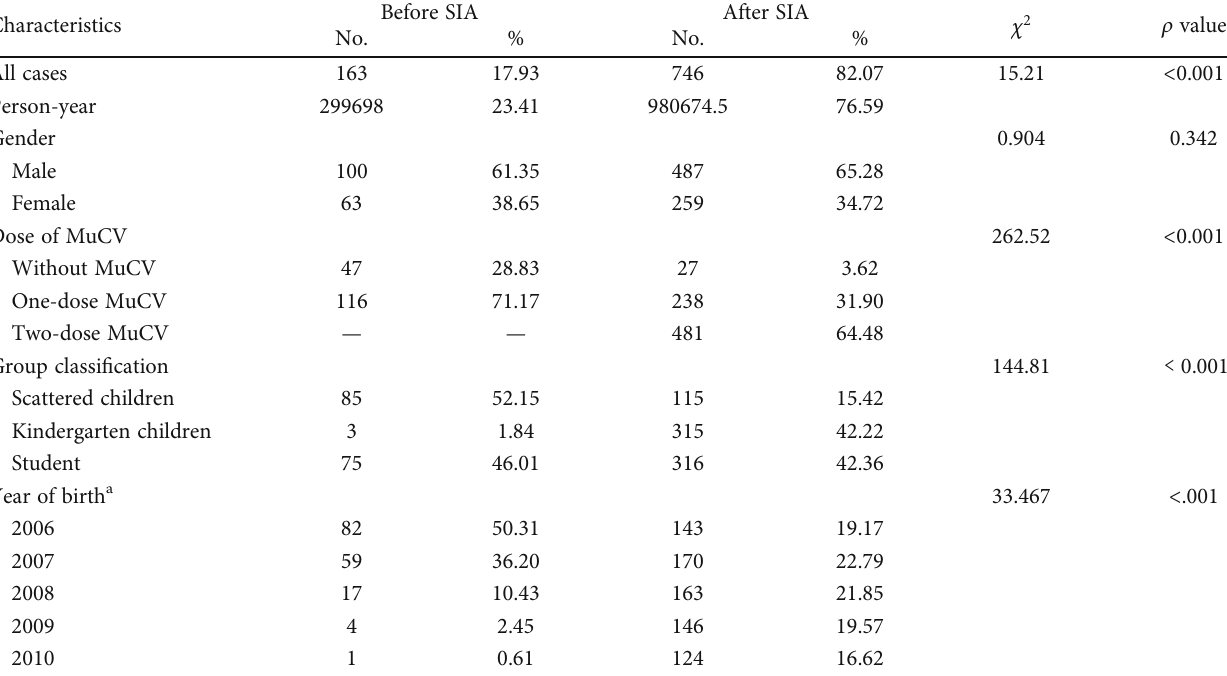
Table 1: Basic characteristics of mumps among children born from 2006 to 2010 in Quzhou.